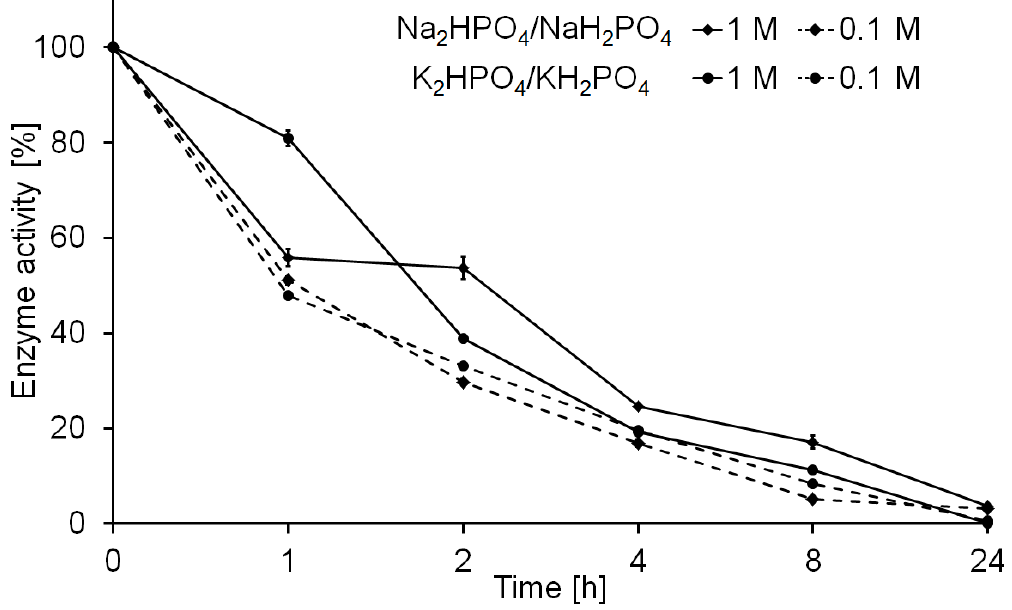
Figure 1. Immobilization of Candida antarctica lipase B (CaLB) onto Accurel MP 1000 (polypropylene) beads in different buffer systems at pH 8, according to the relative remaining activity on para-nitrophenylbutyrate in the supernatant of the immobilization reaction. All reactions were performed in duplicates. The figure shows the mean ± SD.